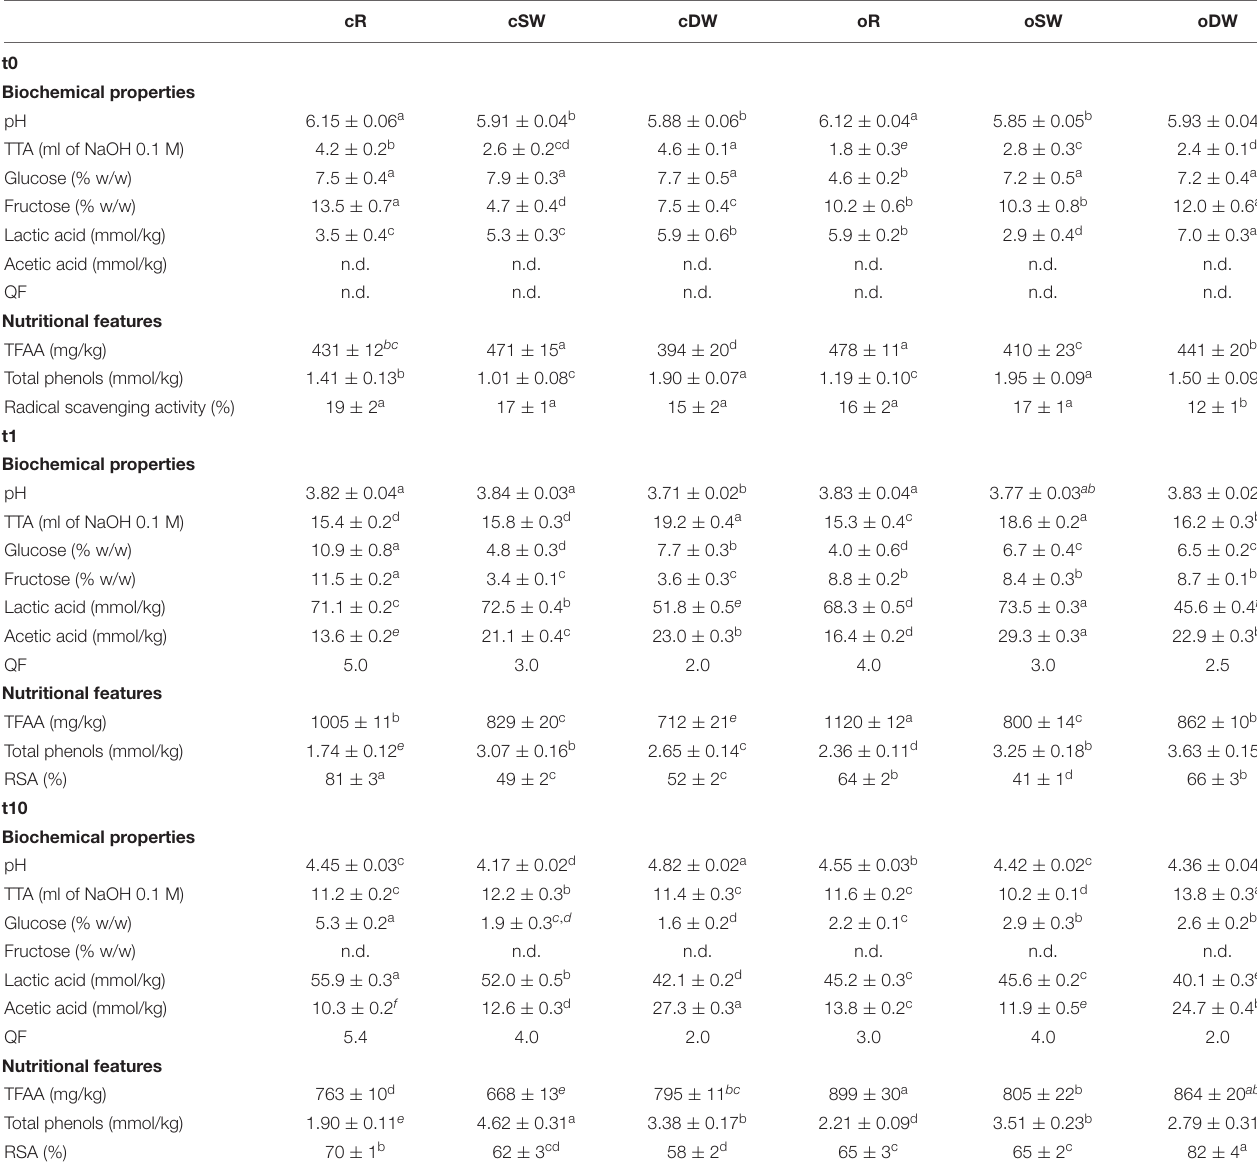
TABLE 3 | Biochemical and nutritional characteristics of doughs prior (cR0, cSW0, cDW0, oR0, oSW0, and oDW0) and after 1 (cR1, cSW1, cDW1, oR1, oSW1, and oDW1) and 10 (cR10, cSW10, cDW10, oR10, oSW10, and oDW10) days of propagation. cR cSW cDW oR oSW